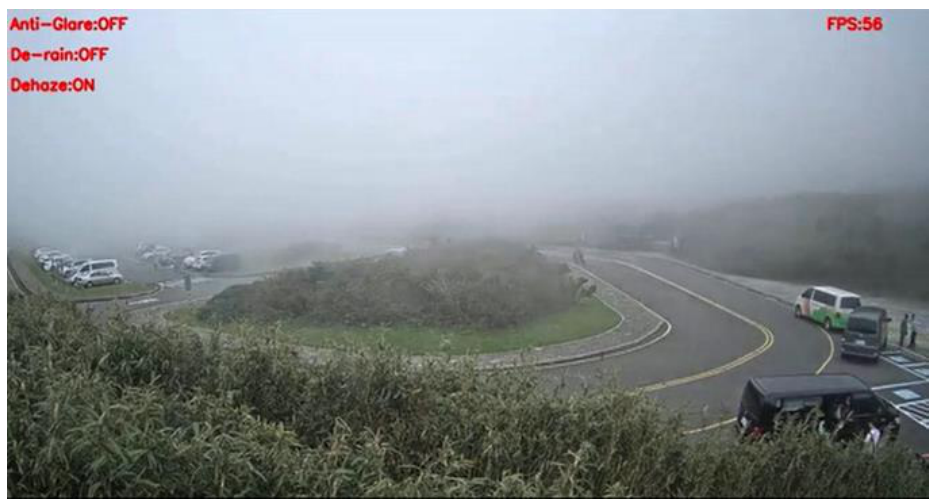
Figure 26. Haze scene image frame detected by YOLOv3.